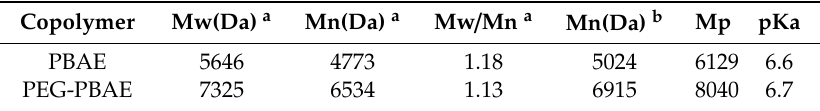
Table 1. Characterization results of PBAE and PEG-PBAE copolymers.